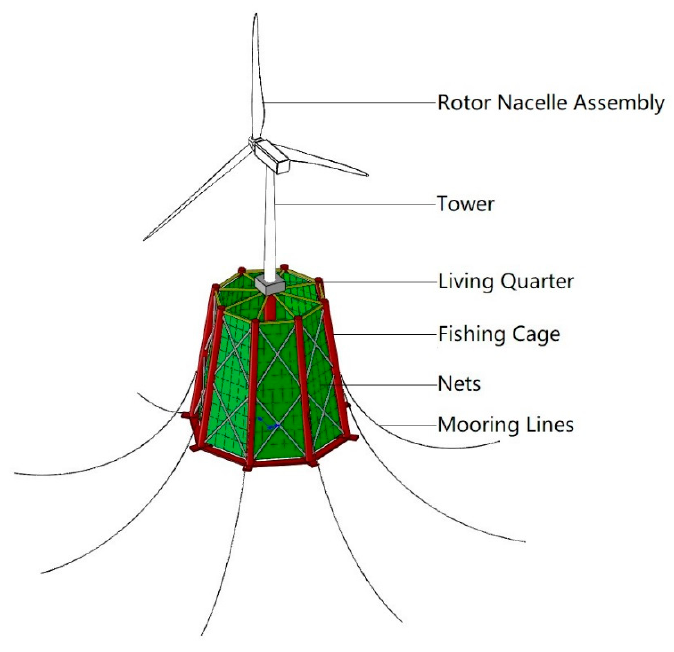
Figure 1. Illustration of the concept of floating offshore wind turbine with a steel fish-farming cage (FOWT-SFFC).